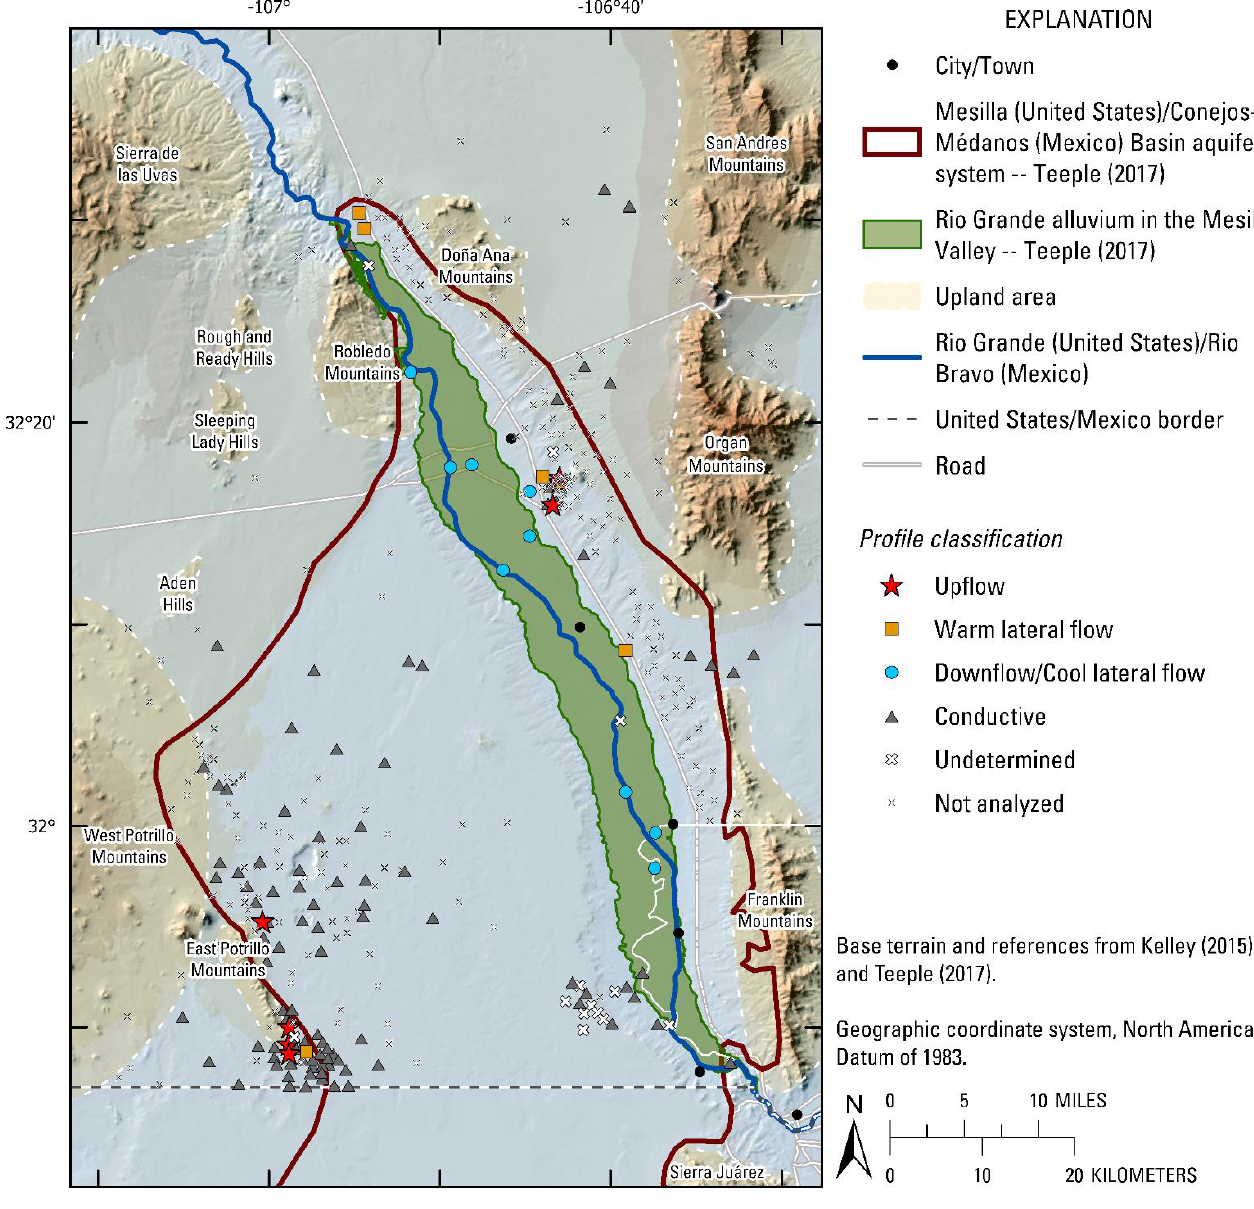
Figure 3. Spatial distribution of profile classifications [21,22].